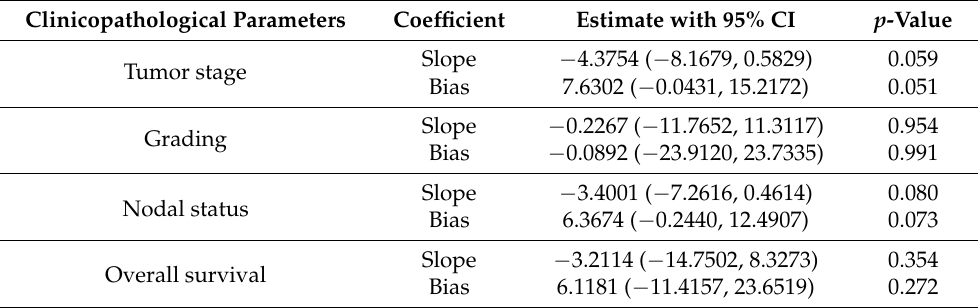
Table 3. Egger’s test to evaluate the publication